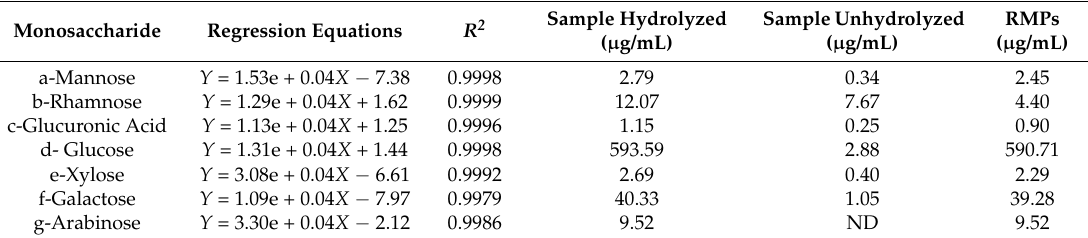
Means and standard deviations are based on three replicates. ND: Not